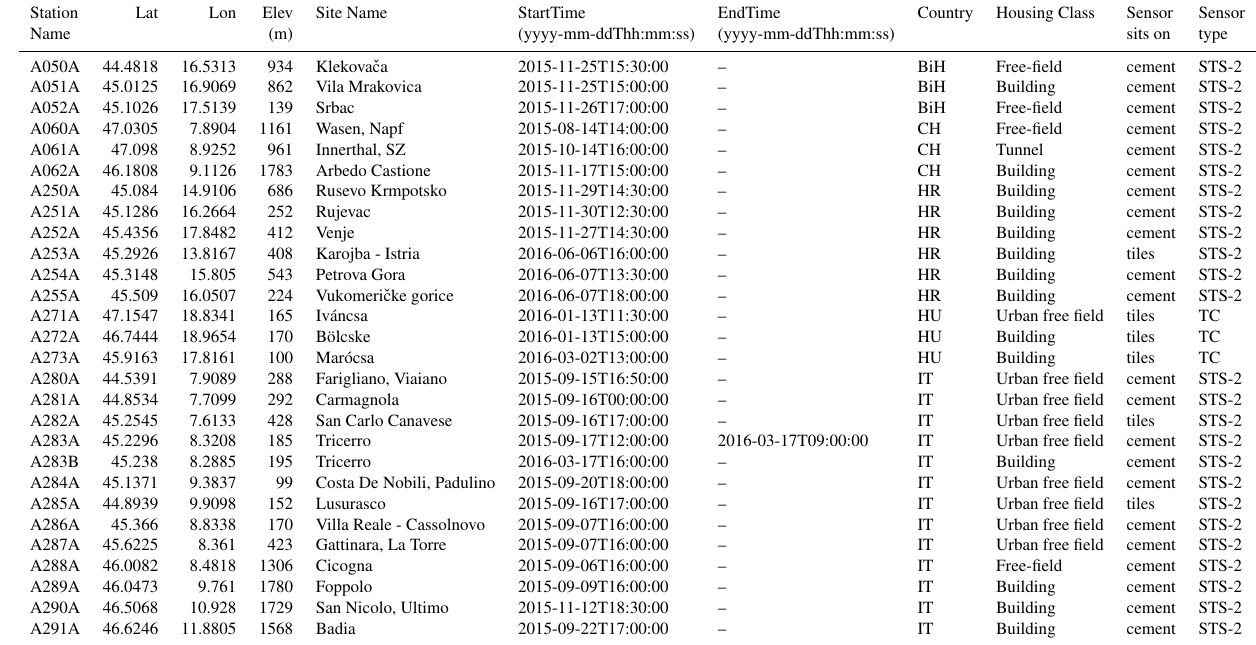
Table 1. List of the Swiss-AlpArray installed between September 2015 and June 2016, with station name, coordinates, start and end time, type of housing, sensor (TC = Trillium Compact 120s) and country of deployment. The network code is Z3 for all the stations.